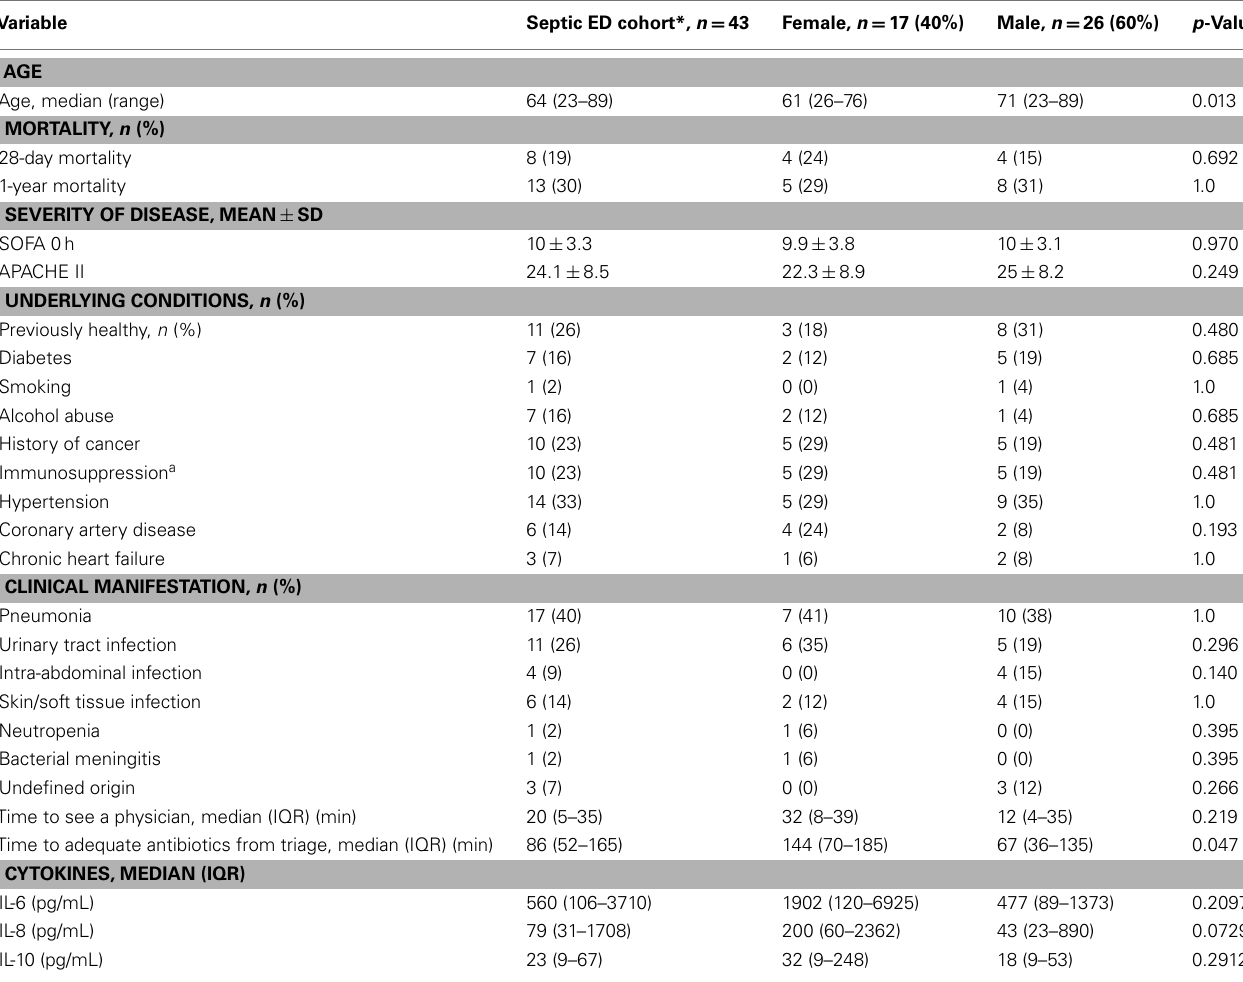
Table 5 | Sepsis patients admitted to ICU through emergency department (ED): baseline patient characteristics in total cohort and in female vs. male patients